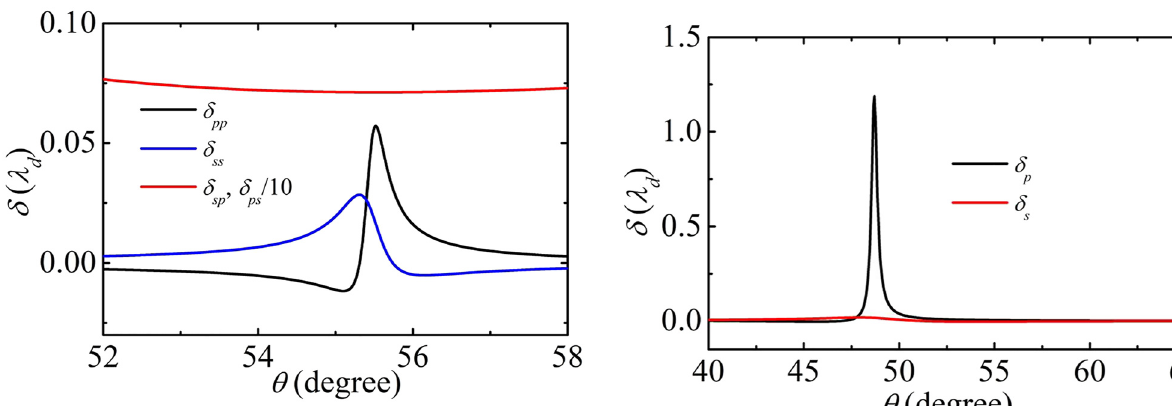
Figure 9: The Imbert–Fedorov shifts of the reflected beams with = 50 nm, d = 200 nm, and 𝜅 = d m c